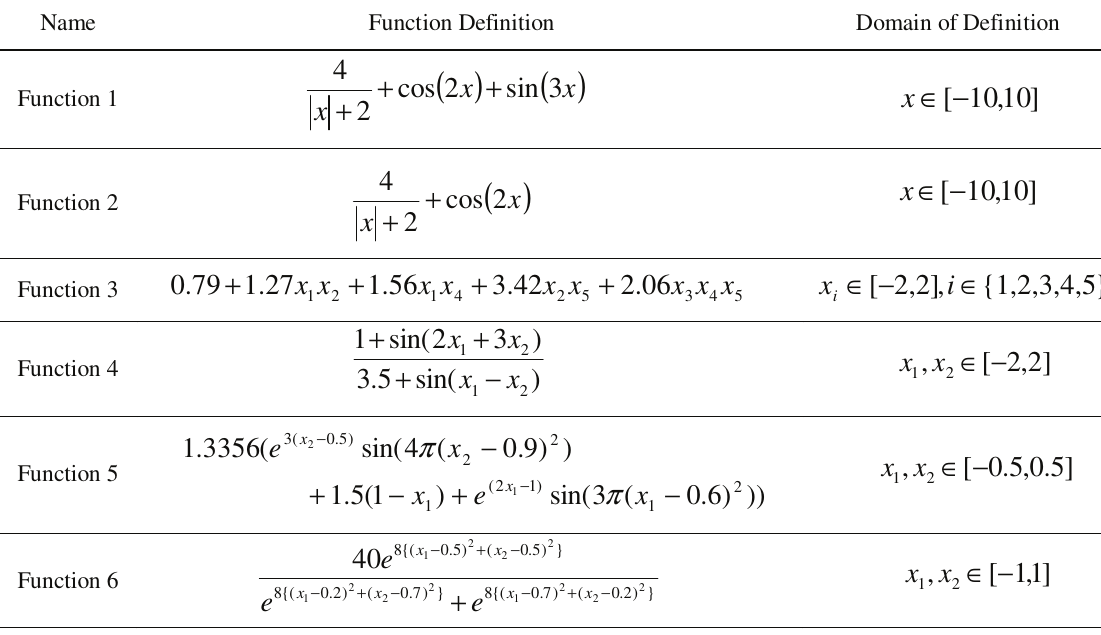
Table 1. Functions used for generating synthetic datasets.